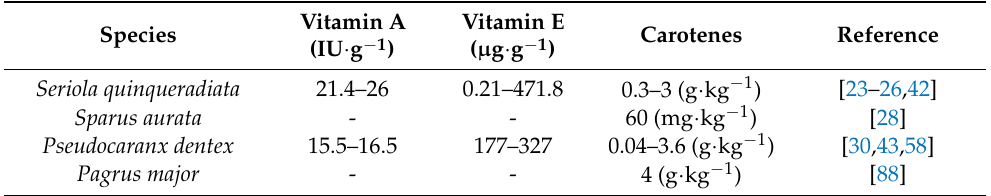
Table 8. Amounts of vitamin A, vitamin E, and carotenes in different diets.